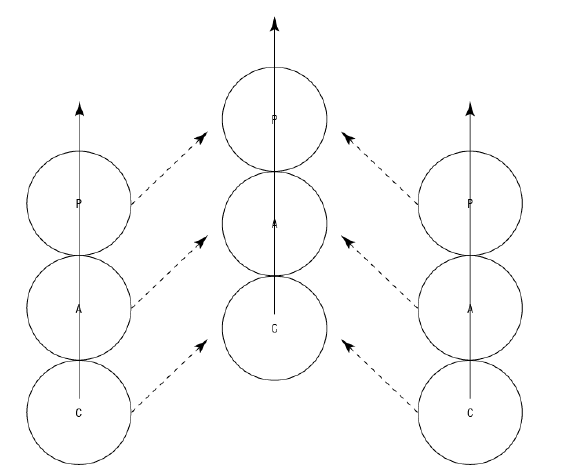
Figure 4: Autonomy Matrix (Hay, 2012, p.19)